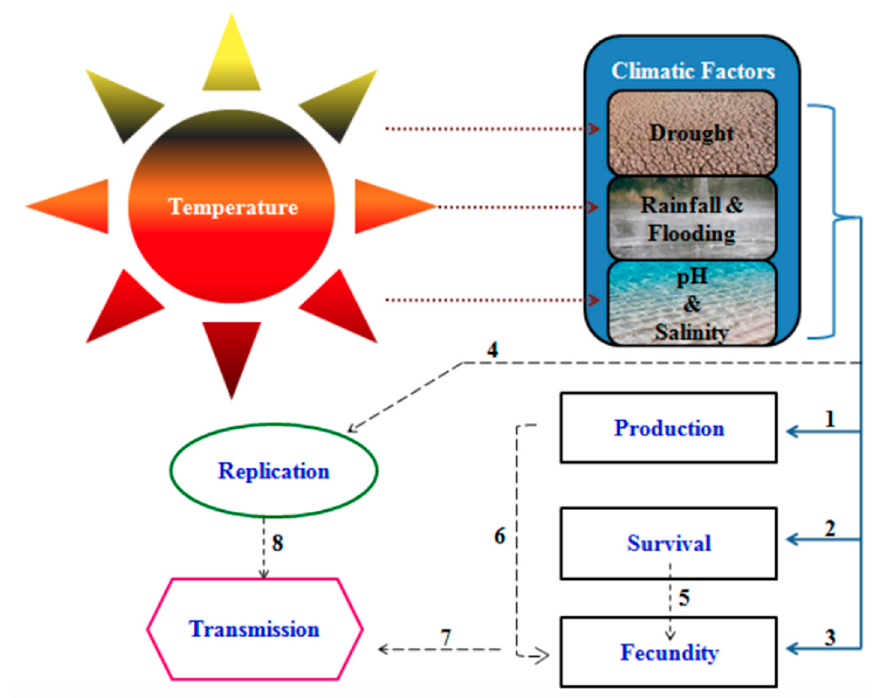
Figure 1. Proposed model eliciting effects of change in climatic factors on Schistosomiasis transmission. 1. Changes in climatic factors are an essential determinant in the production and development of snails, as well as the production and development time of miracidia and cercaria in the intermediate host (snails) and in freshwater depends on climate variability, 2. The snails. as well as miracidia and cercariae in freshwater and intermediate hosts. depends on a change in climatic factors to survive, 3. Climate changes pose a serious influence on the fecundity of the snails and hatching of schistosomes eggs into miracidia, 4. Replication of miracidia in the intermediate host to form sporocyte which in turn produce cercaria, 5. Increase in survival rate leads to an increase in fecundity rate, 6. Climate change enhances the rapid reproduction of snails and the rapid metamorphosis of miracidia into cercaria in the intermediate host, 7. Increase in the fecundity rate of snails enhances the transmission of schistosomiasis by increasing the production number of cercaria within snails, 8. The cercaria penetrates into the definitive human host, thereby metamorphosing into